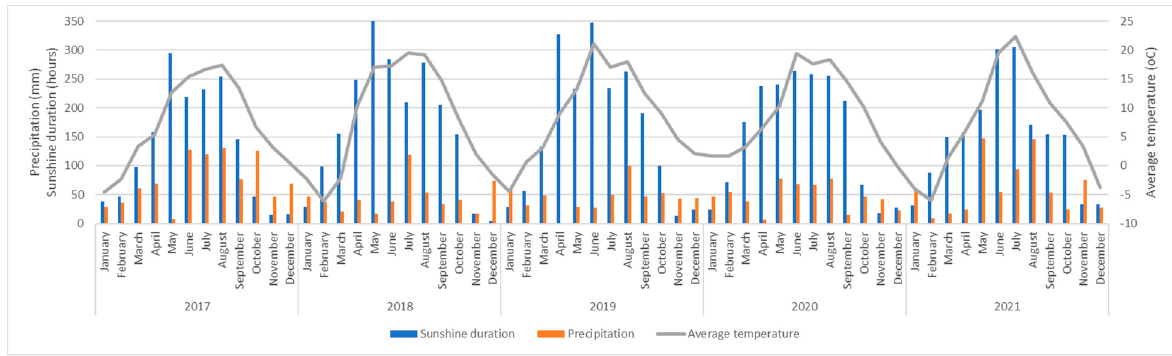
Figure 8. Dynamics of climatic environmental factors in Vilnius over the study years 2017–2021.